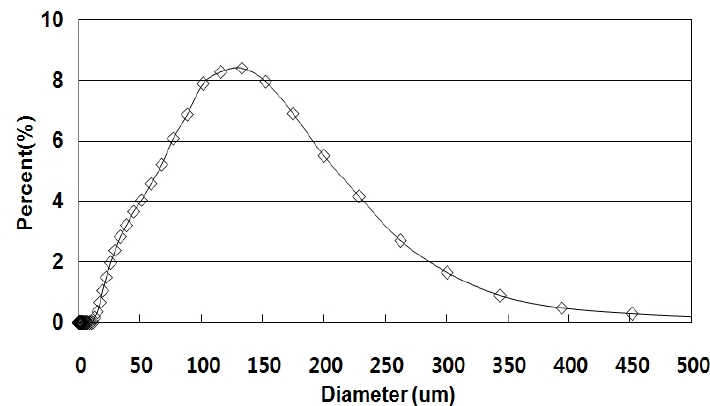
Figure 1. Particle size distribution.